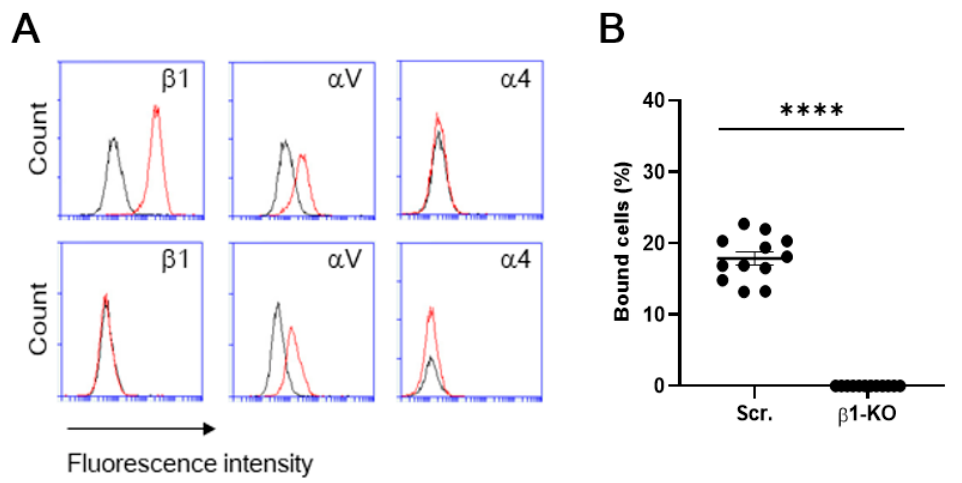
Figure 5. Integrin expression and S1 binding of β 1-control and β 1-KO cells of a human breast cancer cell line (MDA-MB-231). ( A ) The cells were stained with the fluorescently labeled mAbs to integrins. The integrin expression was analyzed by using flow cytometry for β 1-control (Scr.) (upper panel) and β 1-KO (lower panel) cells of MDA-MB-231. Histograms indicate the expression of integrins indicated. Data are representative of three separate experiments. Red lines, MAb; black lines, isotype. ( B ) Cellular binding to S1-Fc was compared between β 1-control (Scr.) and β 1-KO. Results are shown as column scatterplots overlayed with the mean ± SEM of at least 3 independent experiments, in which each sample was triplicated. **** p < 0.0001.